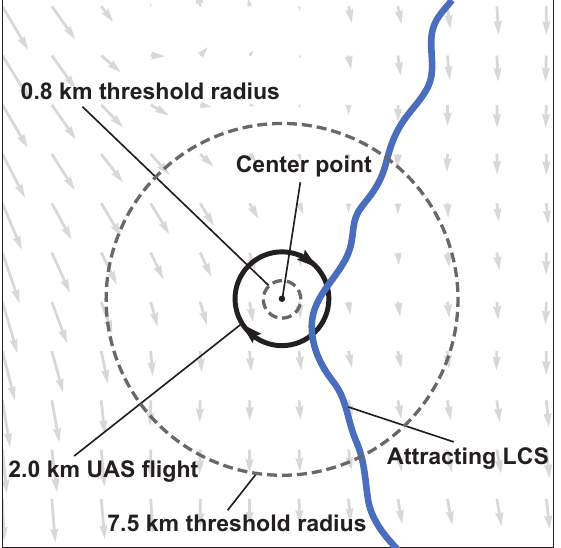
Figure 11. Schematic of Lagrangian coherent structure (LCS) detection showing two examples of threshold radii as dashed lines. An attracting LCS falls within the larger threshold radius but does not fall within the smaller radius. The instantaneous wind field is depicted as the background vector